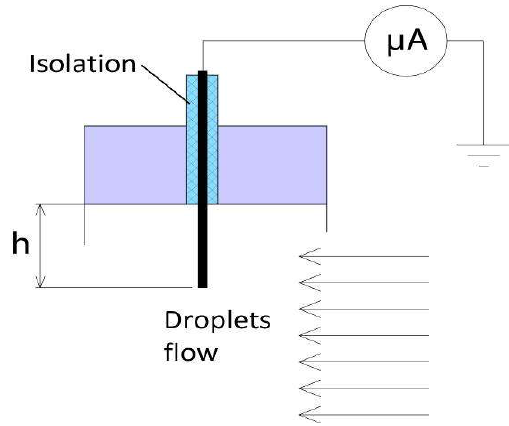
Fig. 5. Electrostatic probe measurement schema